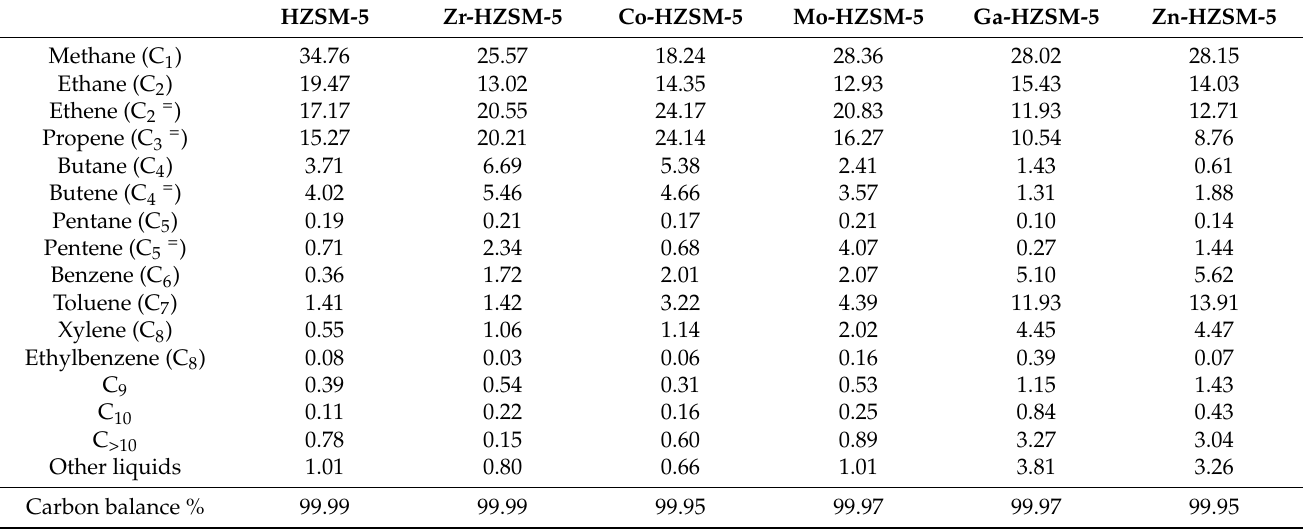
Table 3. The detailed products distribution of the catalysts a .